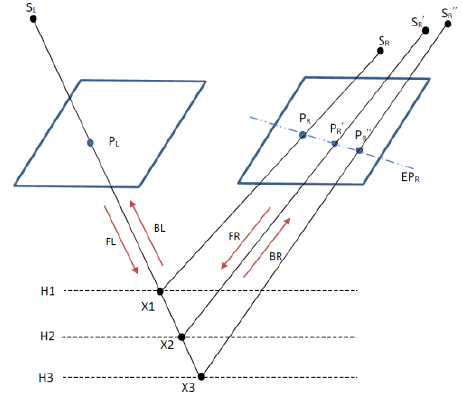
Figure 4. Epipolar geometry of satellite stereo images S L is the perspective center of left image point P L , and P L can be projected to the object space. For example, the image point P L has three corresponding projected points X1, X2 and X3 on three given elevation levels H1, H2 and H3. All of these projected points in the object space can be back-projected to the right image. Then the back-project ray will intersect the right image as a result of three image points P R , P R ’ and P R ’’, which refer to three perspective centers S R , S R ’ and S R ’’. The straight line EP R on the right image plane is simulated by the back-projected image points, which is called the quasi-epipolar line. Symmetrically, P R is projected to the elevation levels in the object space and then back-projected to the left image. The corresponding quasi- epipolar line on the left scene is attained. Previous researches have pointed out, that the epipolar line of satellite images is not a straight line but more like a hyperbola. But when the image coverage is small, the influence of the error caused by the simulation is negligible. In this case, the epipolar curve can be simply simulated as a straight line (Kim, 2000; Habib, et al., 2005; Wang, M., et al., 2011). In this paper, each epipolar curve is approximated by an individual straight line in the whole image.